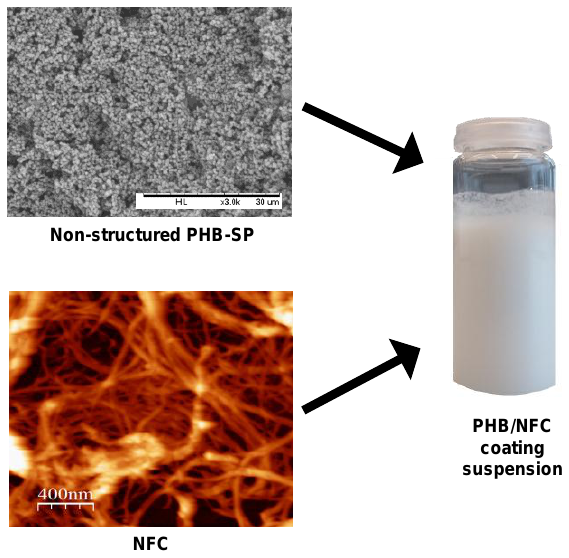
Figure 9. Scheme for preparing PHB-SP/NFC coating slurry used for paper coatings.